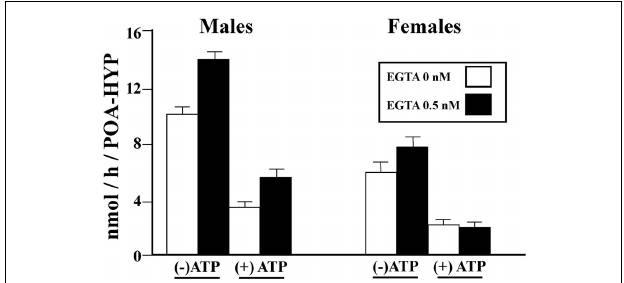
FIGURE 5 | Calcium-dependent changes in aromatase activity in the male and female quail HPOA. Males and female tissue homogenates were exposed to 0 or 0.5mM EGTA combined with the presence or absence of ATP/Mg 2 + /Ca 2 + (ATP), thus creating four different experimental conditions in each sex. Redrawn form data in Konkle and Balthazart